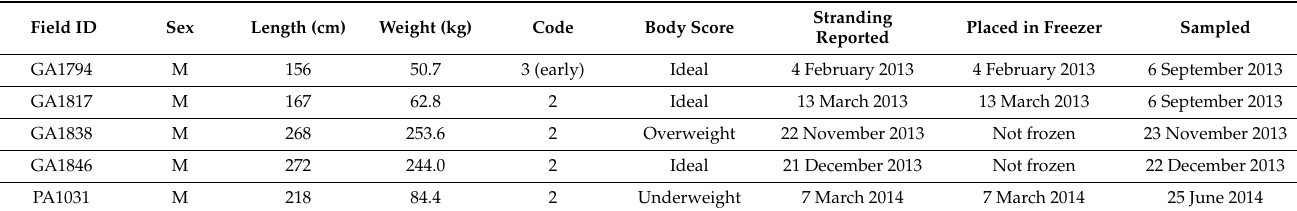
Table 1. Stranding data and sampling timeline for carcasses examined in this study. Decomposition codes followed Geraci and Lounsbury [22] and body scores followed Mazzoil et al. [24].